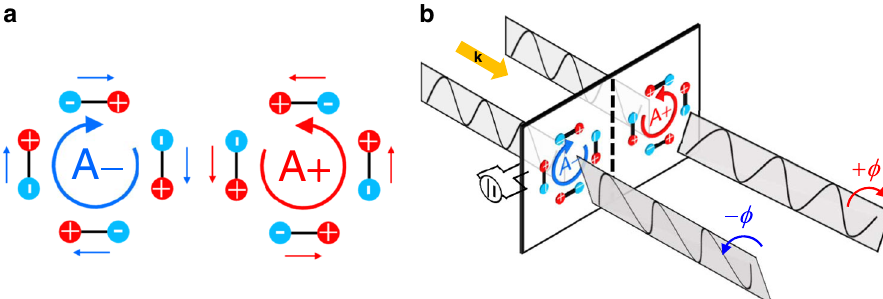
P ´ p i , which characterizes i r i